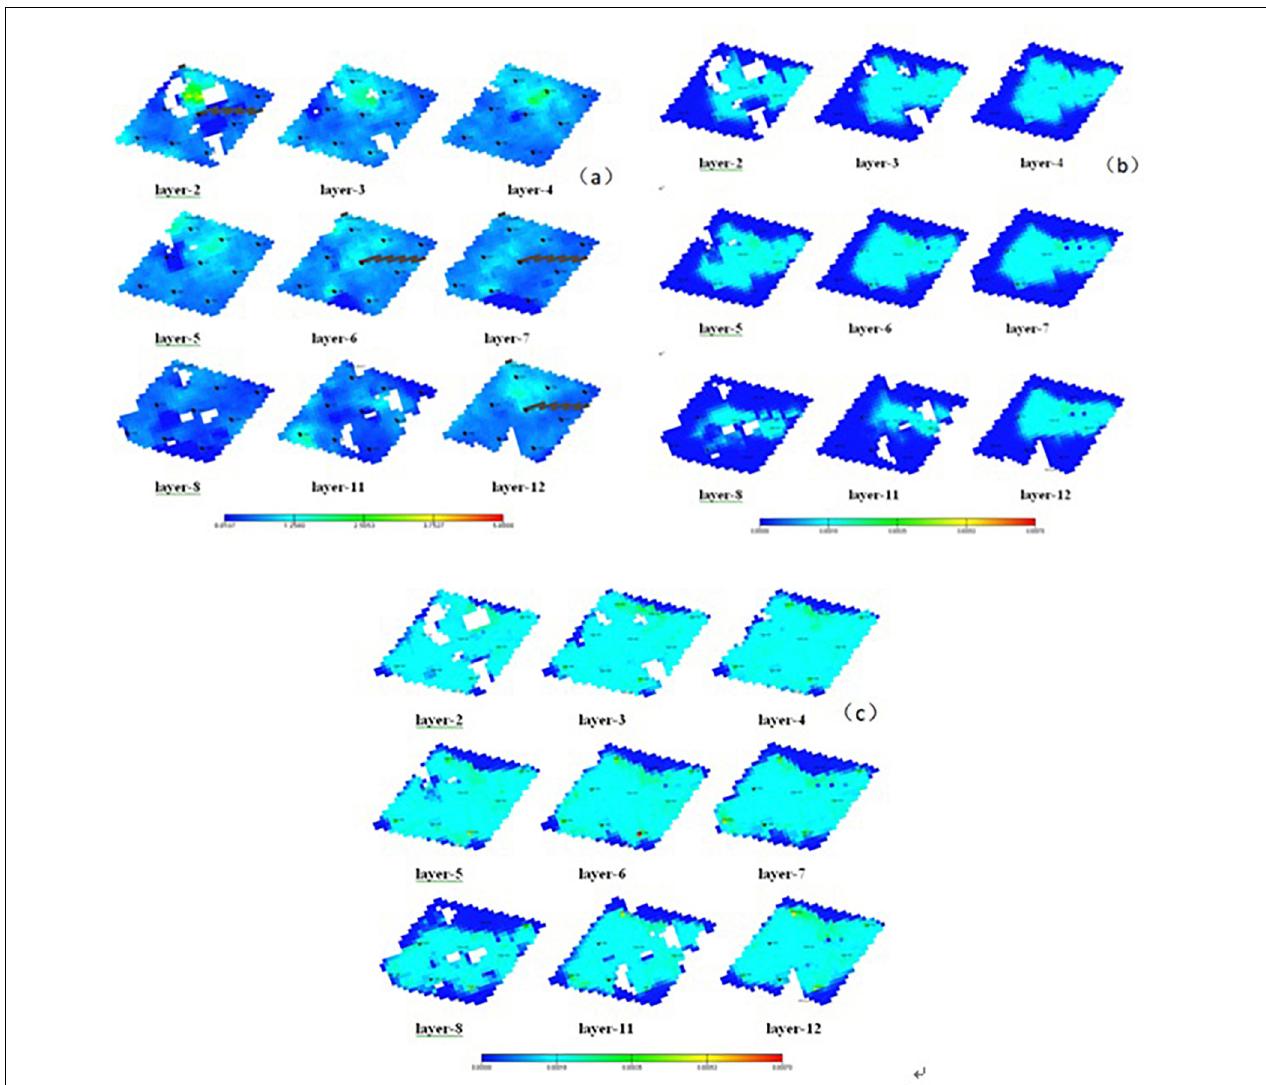
FIGURE 6 | (A) Formation permeability at different horizons. (B) Inorganic salt precipitation distribution after 10 years of production. (C) Inorganic salt precipitation distribution after 40 years of production.